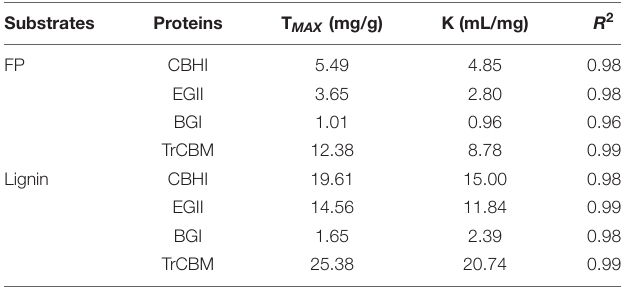
TABLE 2 | Parameters of Langmuir isotherm adsorption models of CBHI, EGII, BGI, and TrCBM on FP and lignin extracted from LPCS. Substrates Proteins